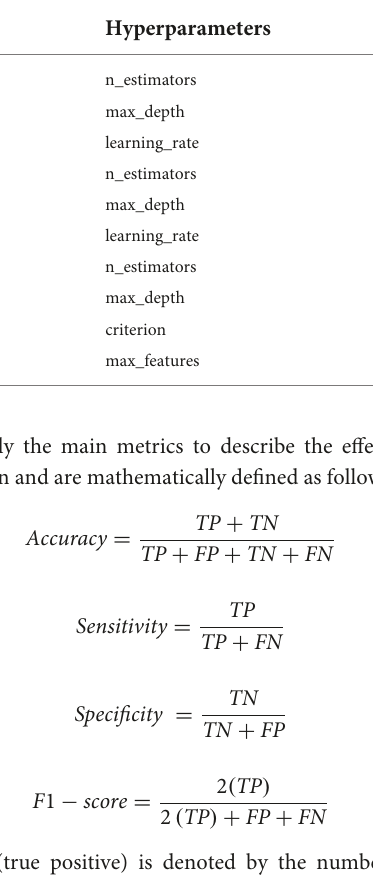
TABLE 2 Hyperparameters of the three models used in this